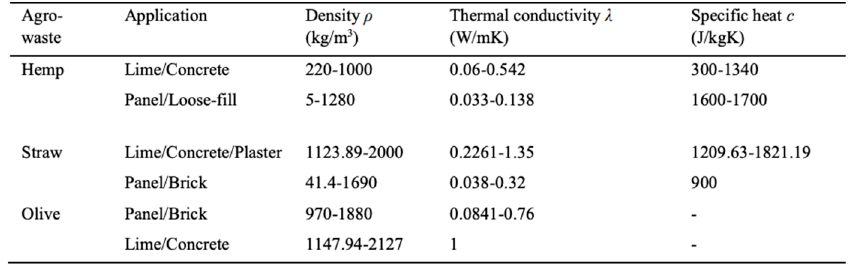
Figure 6. Thermal properties of biomass residues